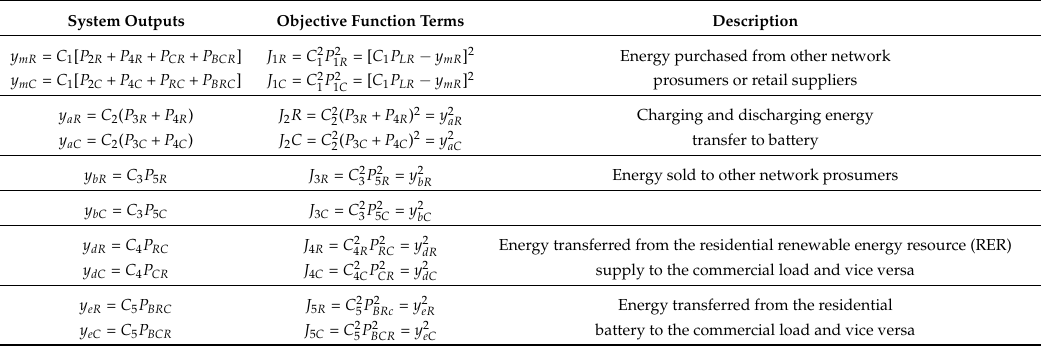
Table 1. System outputs and objective